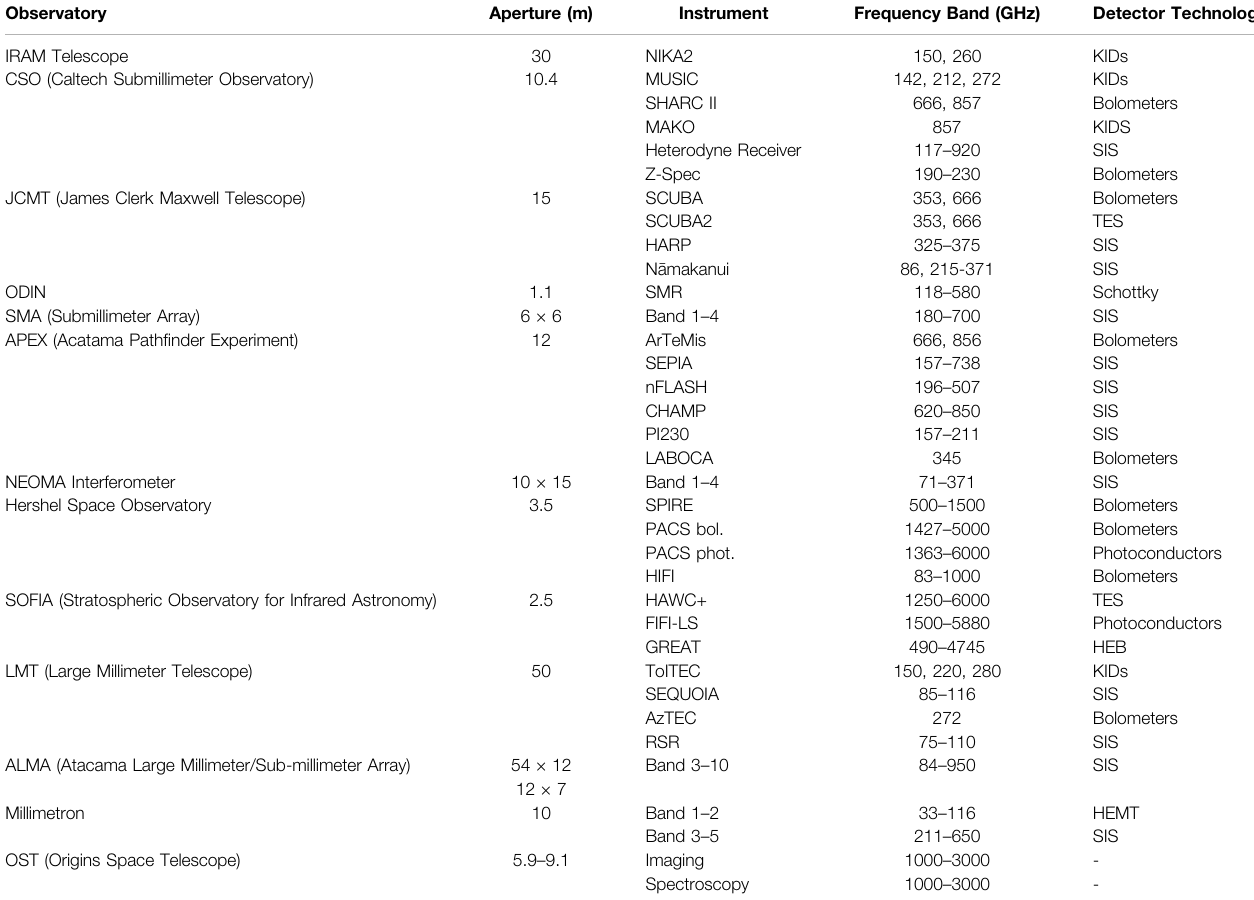
TABLE 1 | Examples of the sensitivities achieved by selected observatories operating in the THz/F-IR range.